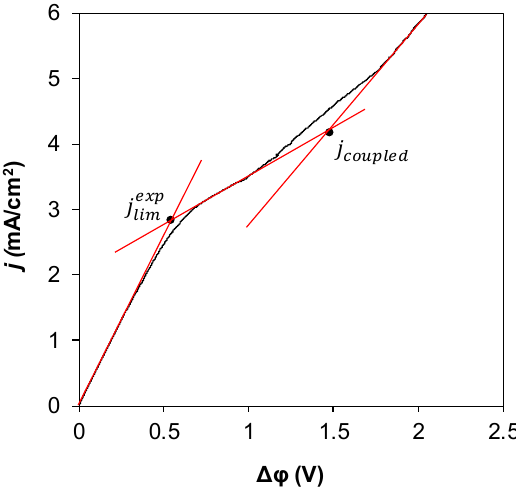
Figure 3. Determination of the experimental limiting current and the current at which the coupled effects of concentration polarization arise. The resistance of the membrane can also be determined from the slope of the tangent drawn to the initial part of the curve.